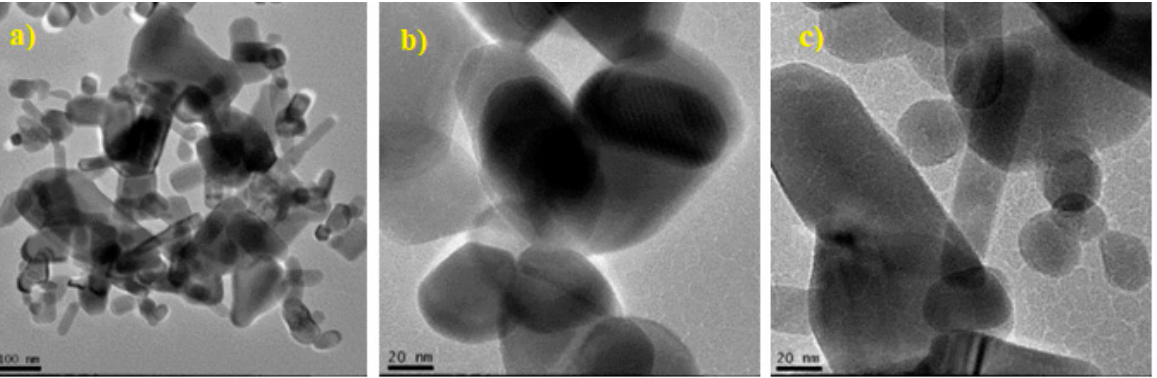
Figure 2. ( a – c ) TEM images of pure ZnO nanoparticles.